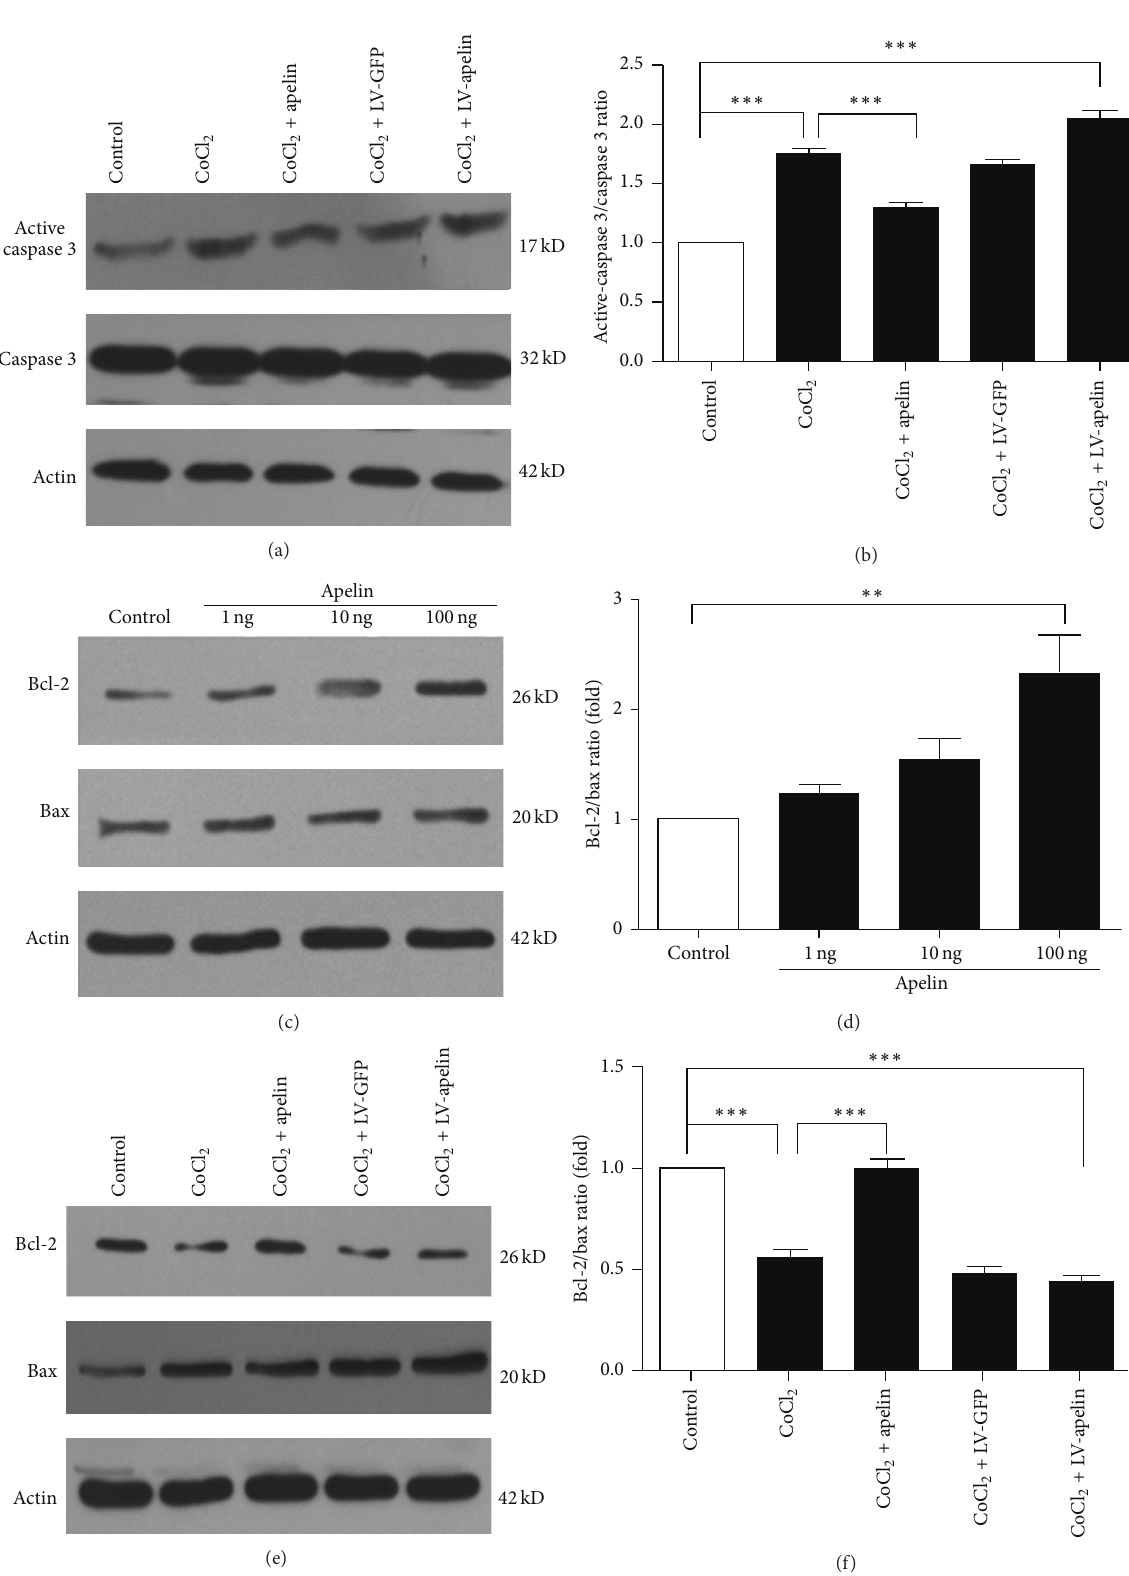
Figure 8: Effect of apelin on hypoxia-induced apoptosis in rat retinal pericytes. (a) Active-caspase 3 protein level significantly increased 12 h after hypoxia injury ( 𝑃 < 0.001 ). Apelin significantly decreased its levels after hypoxia injury ( 𝑃 < 0.01 ). (c and e) Effects of apelin on Bcl-2 and Bax protein expression in rat retinal pericytes. Cells were incubated with apelin and LV-apelin knockout under hypoxia. Western blot analysis was quantitated by densitometry of autoradiographs, and the relative mean ratio of Bcl-2/Bax was increased in apelin group ( 𝑃 < 0.001 versus con.) and reduced in Lv-apelin knockdown group ( 𝑃 < 0.001 versus